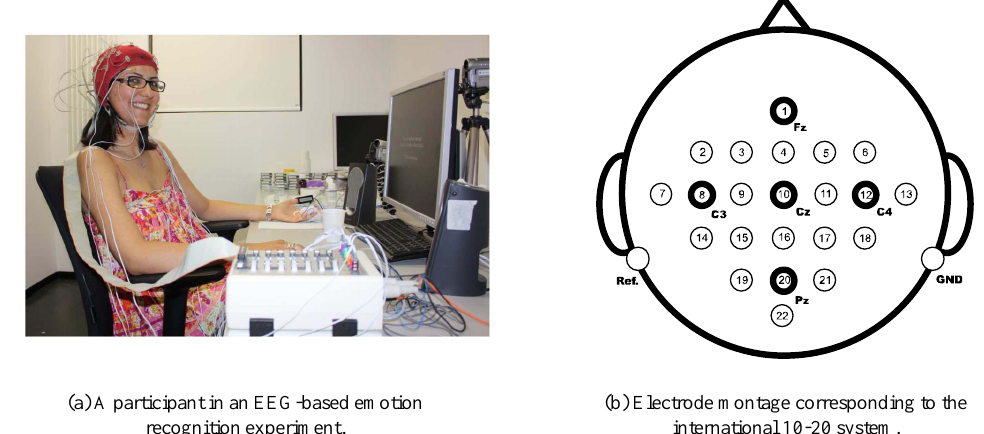
Figure 7. A participant in an EEG-based emotion recognition experiment [88] and electrode montage of BCI Competition IV-IIa [89]. Reprinted with permission from Ref. [88]. Copyright 2011